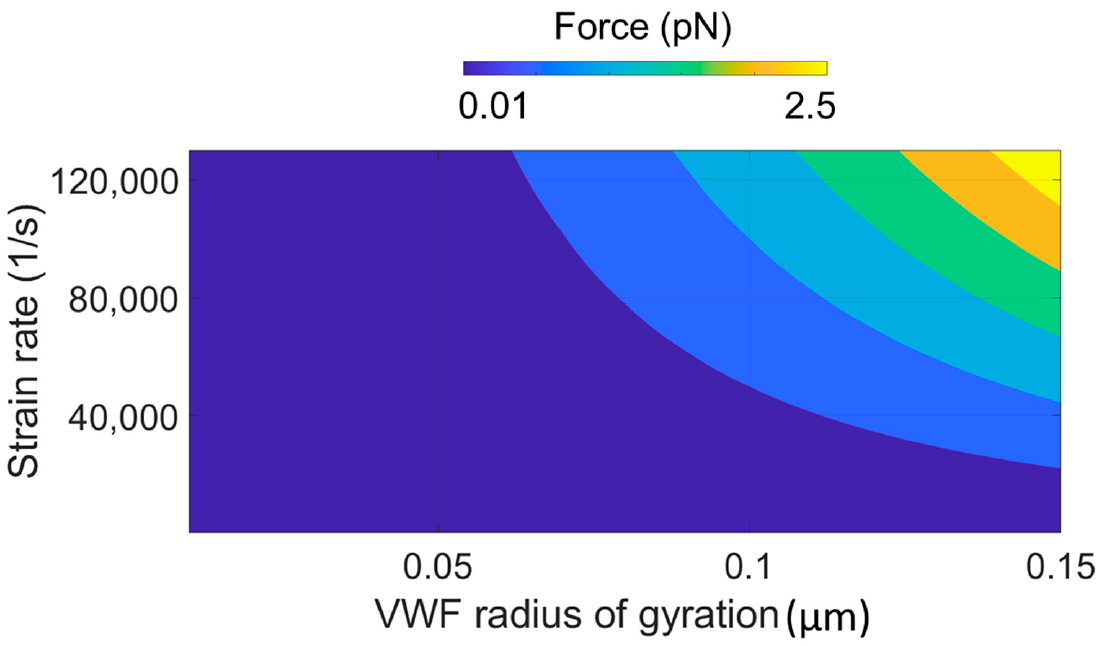
Figure 2. Force applied to VWF in laminar flow when the Deborah Number is much larger than 1.